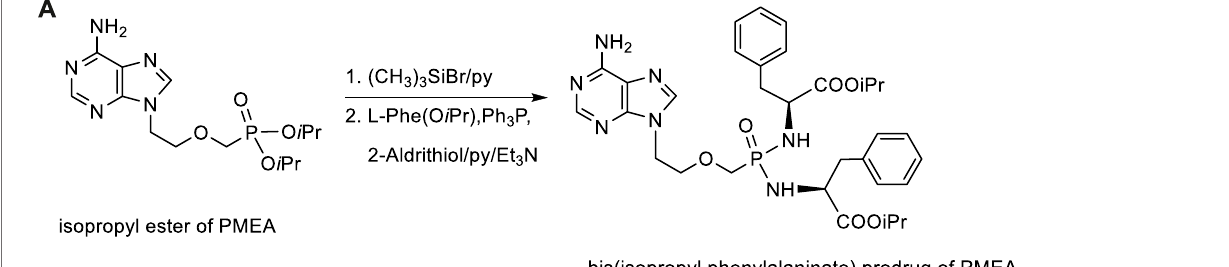
Frontiers in Chemistry |